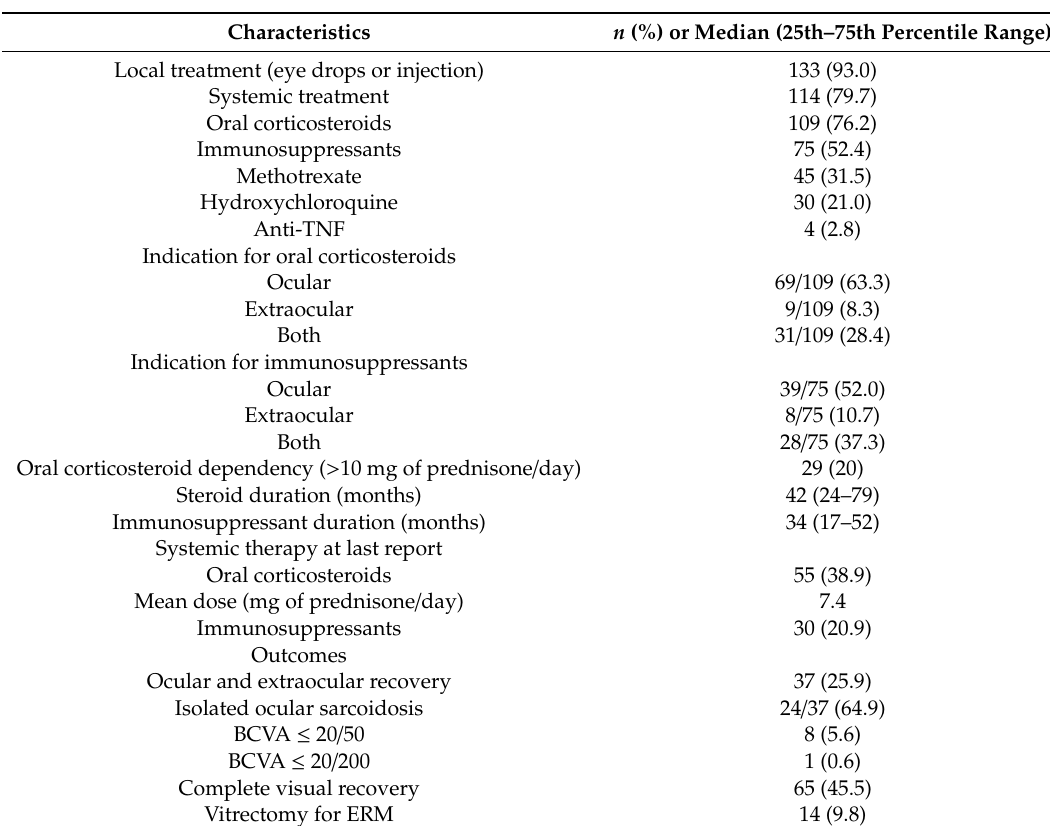
Table 4. Treatments and outcomes of the 143 patients with sarcoid uveitis.